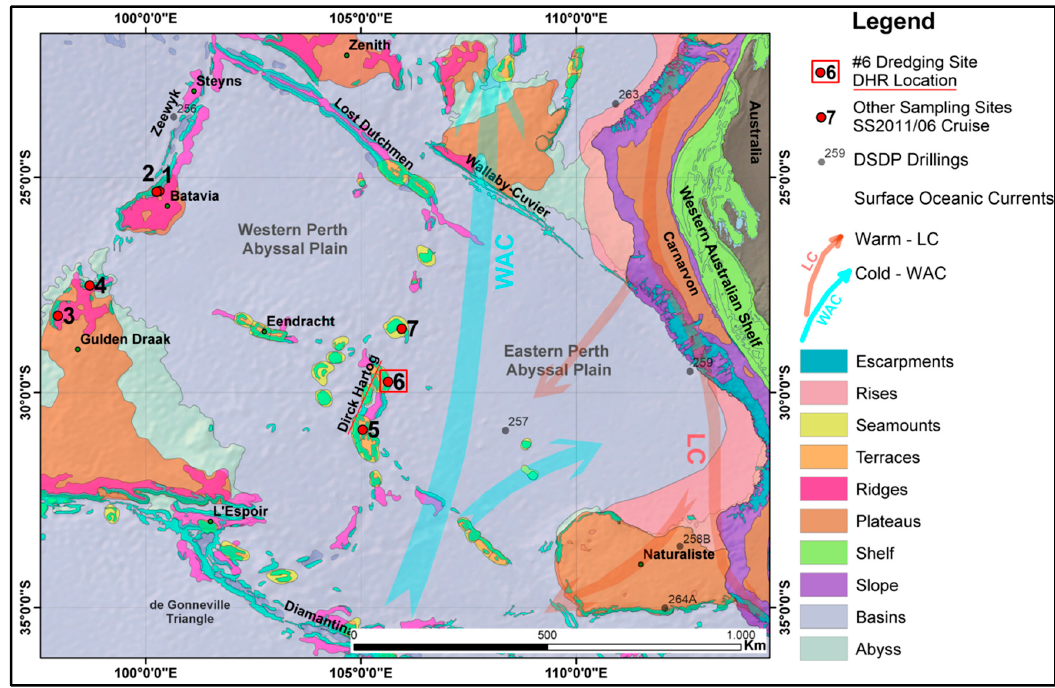
Figure 1. The DHR sampling sites location collected during cruise SS2011/06. Undersea feature names and borders follow General Bathymetric Chart of the Oceans (GEBCO Gazetteer) [36].